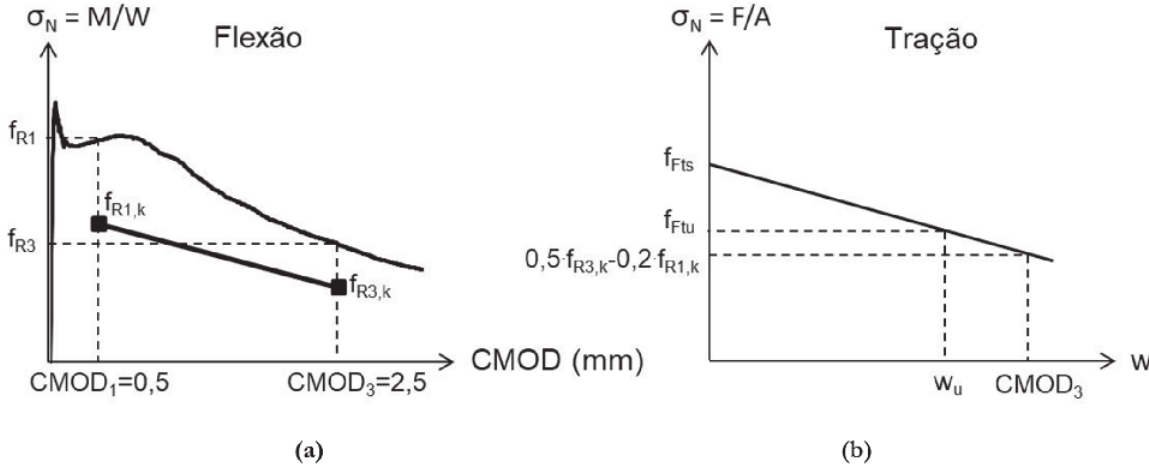
Tensões residuais do CRF: a) curva à flexão; b) curva linear à